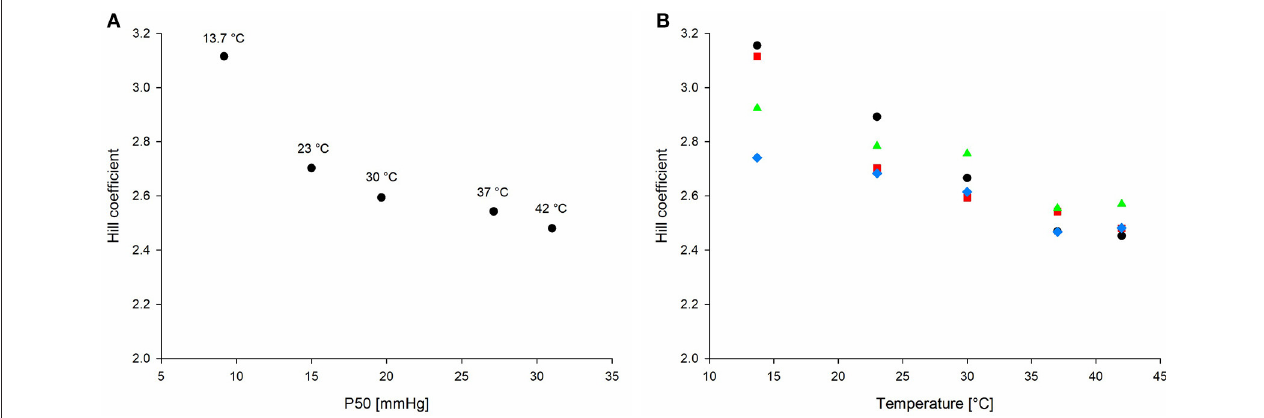
FIGURE 6 | (A) Correlation of Hill coefficient (HC) with P50. HCs decrease with increasing P50. (B) Mean Hill coefficient over all 20 combinations of PCO 2 and temperature (black circle 20 mmHg, red square 40 mmHg, blue rhombus 60 mmHg, and green triangle 80 mmHg). P50, oxygen partial pressure at which 50% of hemoglobin is saturated with